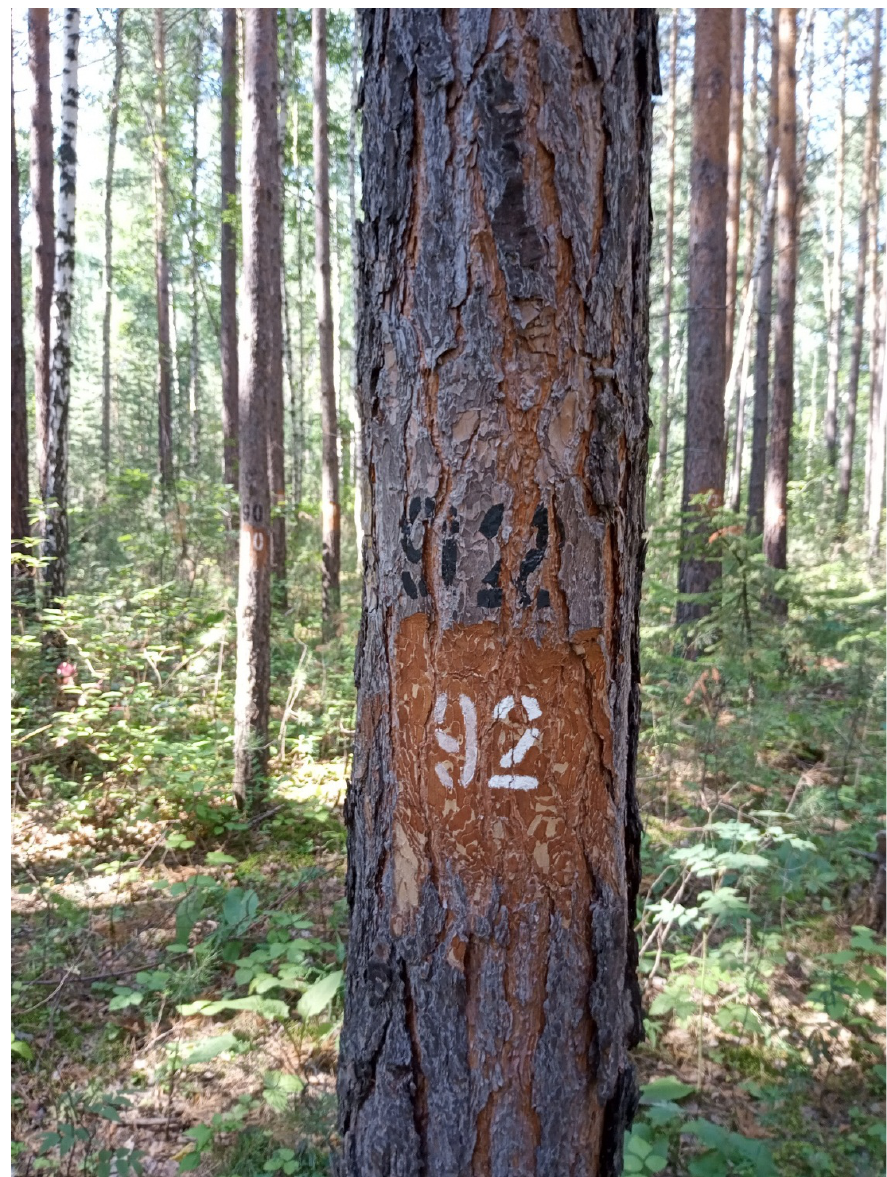
Figure 1. Numbered trees in permanent sample plot 2 in a middle-aged pine stand in 2019.